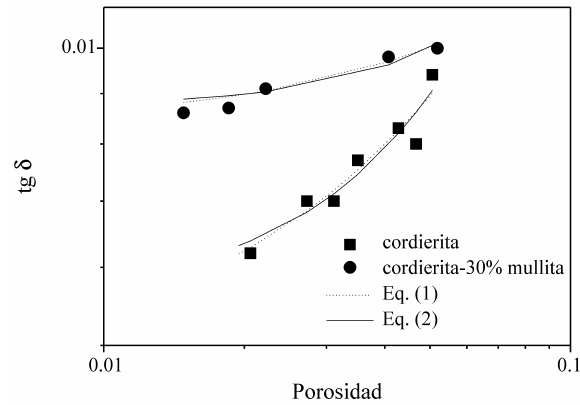
Figura 4. Resultados experimentales de tg δ en función de P para los materiales de cordierita y cordierita-30% mullita y curvas de ajuste obtenidas con los modelos 1 y 2.